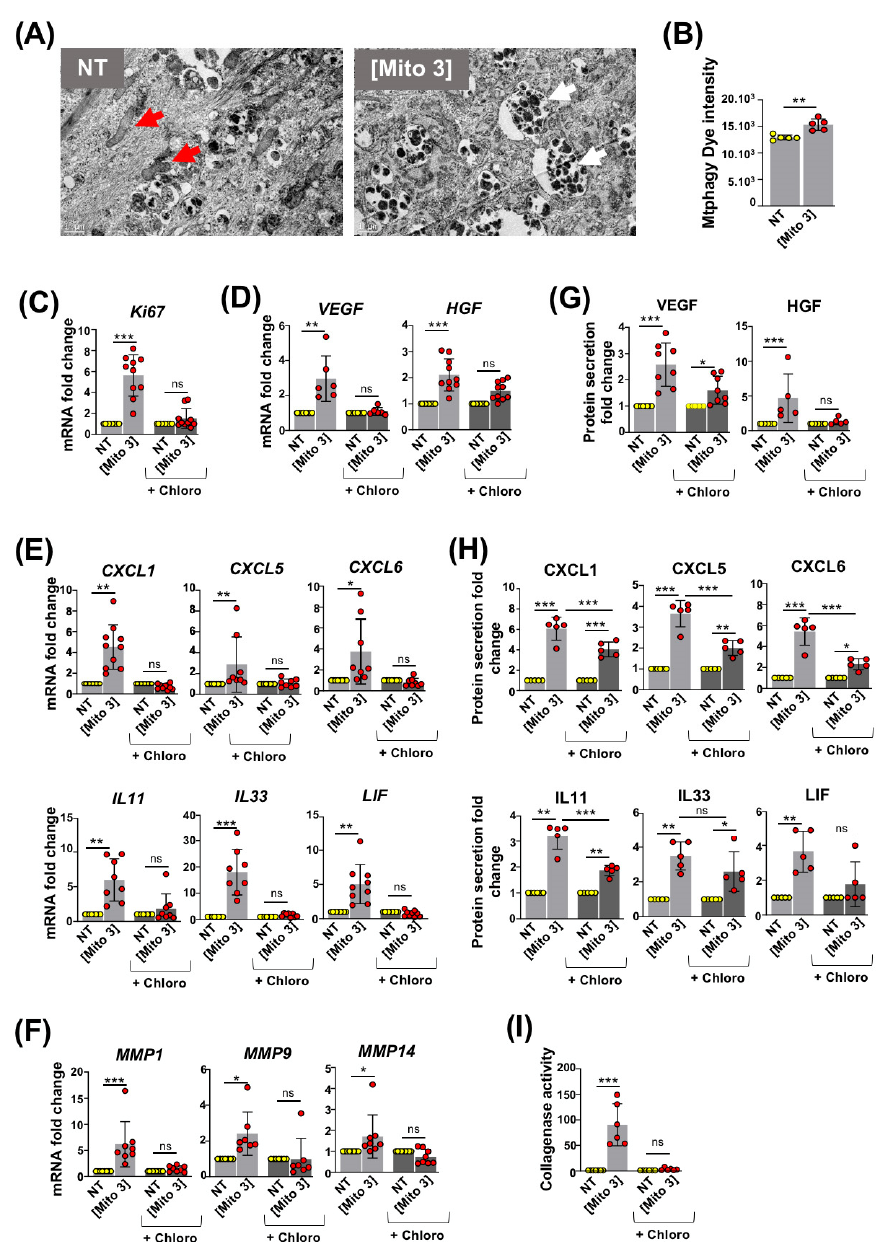
Figure 3. Degradation of cardiac mitochondria is required for MSC activation. ( A ) Transmission electron micrographs taken 24 h after exposure of MSCs to cardiac mitochondria (right panel, Mito 3 concentration; left panel, non-treated MSCs). Red arrows: intact mitochondria. White arrows: au- tophagolysosomes. Scale bar: 1 µ m. ( B ) Mtphagy dye fluorescence intensity in cardiac mitochondria- preconditioned MSCs in reference to untreated ones ( n = 10). ( C – I ) Prior cardiac mitochondria transfer at the Mito 3 concentration, MSCs were treated or not with chloroquine (Chloro) and compared with their respective controls. ( C – F ) Relative mRNA levels of ( C ) Ki67 ( n = 10); ( D ) VEGF ( n = 6) and HGF ( n =10); ( E ) CXCL1 , CXCL5 , CXCL6 , IL11 , IL33 and LIF ( n ≥ 8); (F) MMP1 , MMP9 and MMP14 ( n ≥ 7). ( G , H ) Relative protein secretion levels of ( G ) VEGF ( n = 8) and HGF ( n = 5) and ( H ) CXCL1, CXCL5, CXCL6, IL11, IL33 and LIF ( n = 5). ( I ) Relative collagenase activity ( n =